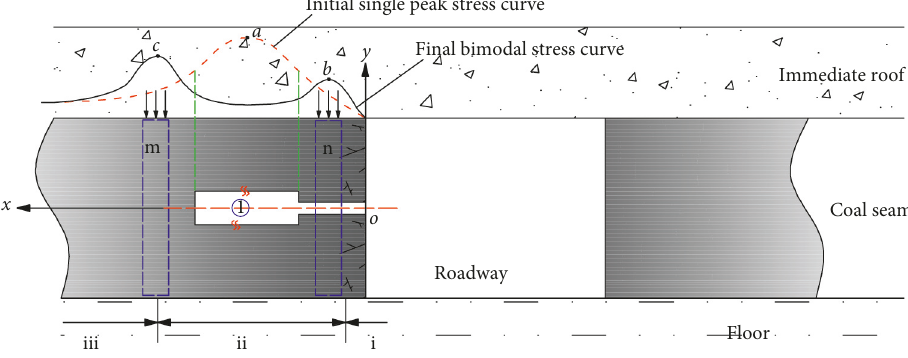
Figure 8: The schematic diagram of prevention mechanism of rock burst in roadway rib. Note: I, crush zone; ii, elastoplastic zone; iii, elastic zone; ① , a pressure relief